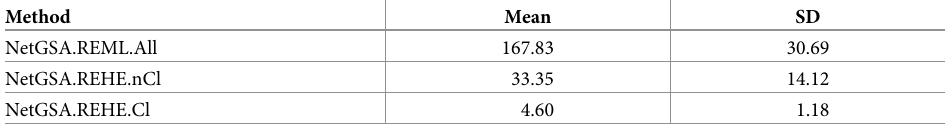
Table 1. Timing results (in minutes) for NetGSA with REML and REHE with and without network clustering for both the prostate and breast cancer datasets. Method